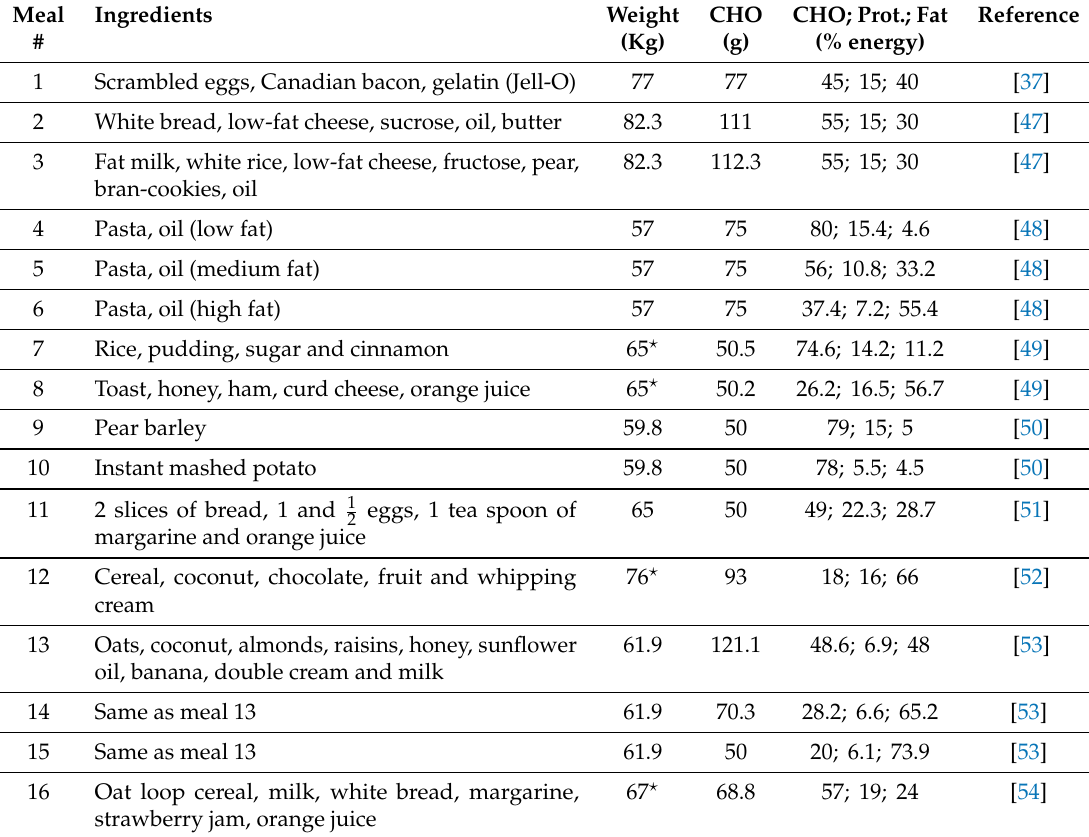
Table A1. Mixed meals information and bibliographic